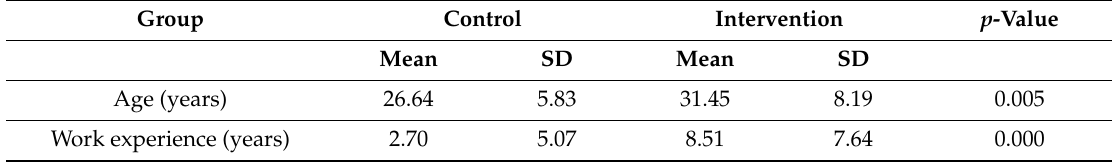
Table 1. Mean age and work experience of the subjects in the intervention and control groups. Group Control Intervention p -Value